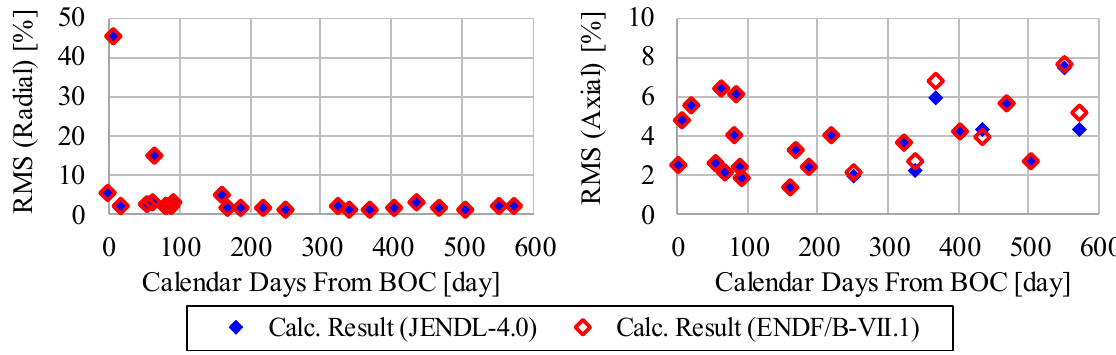
Figure 5. Boron Letdown Results of Cycle 1.